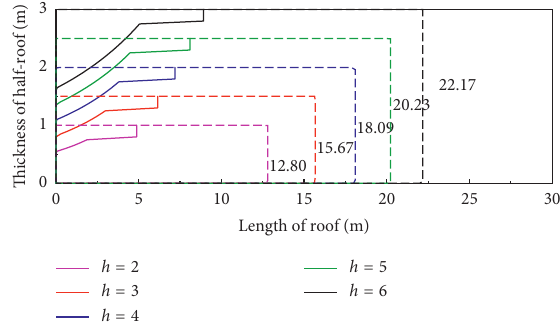
Figure 9: Effect of different roof thicknesses on the boundary of crack-affected